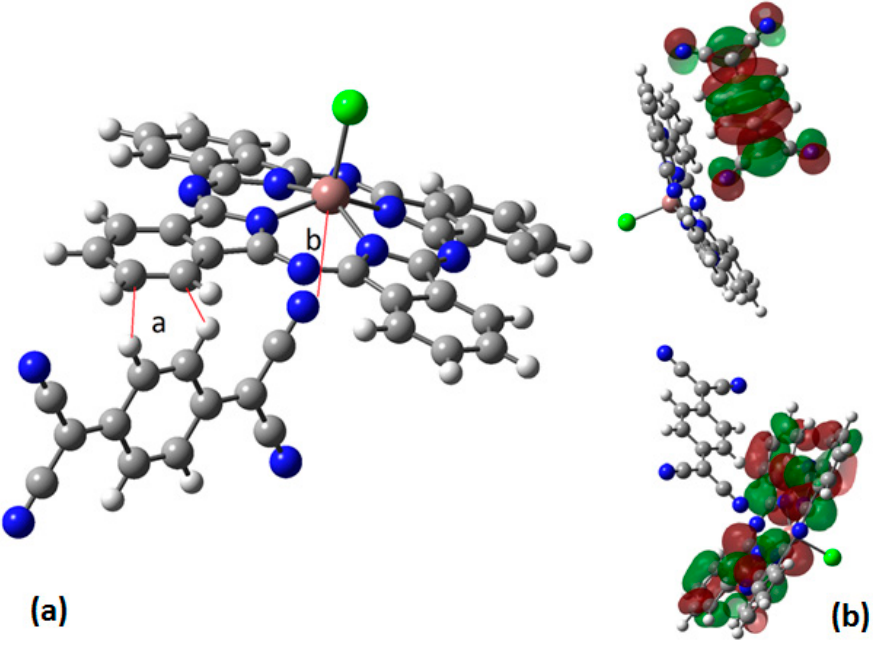
Figure 7. ( a ) Structure and ( b ) HOMO-LUMO orbitals for InPcCl + TCNQ. Table 3. Highest Occupied Molecular Orbital (HOMO) and Lowest Unoccupied Molecular Orbital (LUMO) values and comparison among experimental and theoretical bandgap results of obtained compounds.